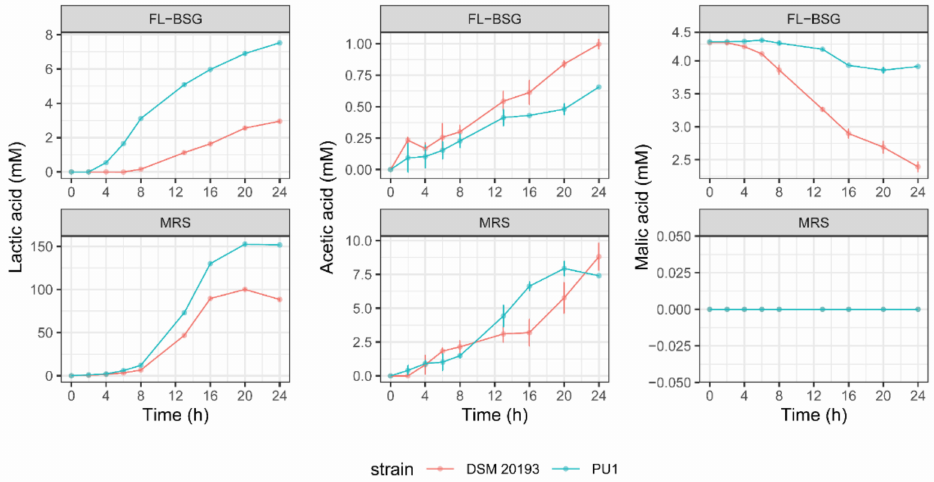
Figure 1. Organic acids production (mM) of Leuconostoc pseudomesenteroides DSM 20193 and Lactiplan- tibacillus plantarum PU1 during fermentation of Finnish brewers’ spent grain (FL-BSG) and MRS at 30 ◦ C for 24